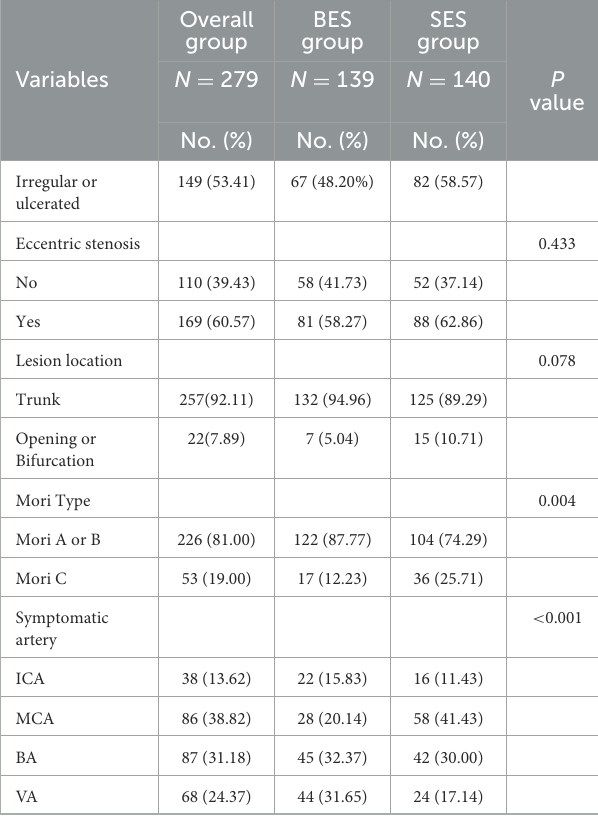
TABLE 1 Baseline categorical variables of patients in the overall group or stent